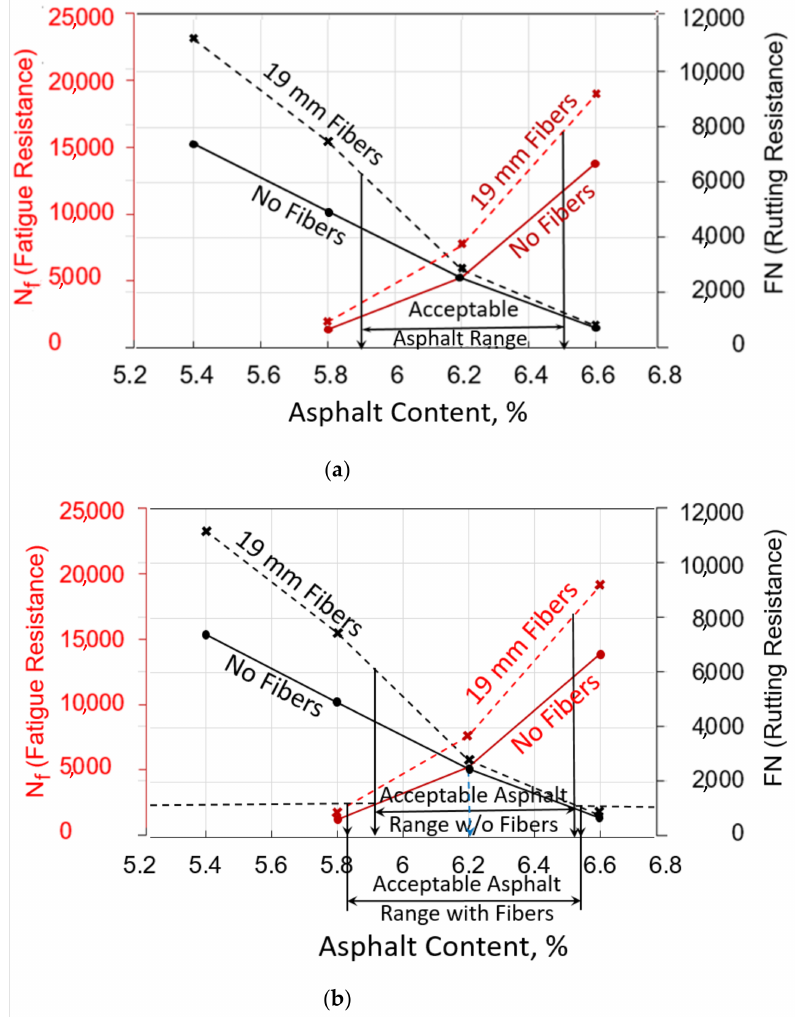
Figure 11. Effect of fibers on BMD: ( a ) improving cracking and rutting resistance, and ( b ) increasing the acceptable range of asphalt